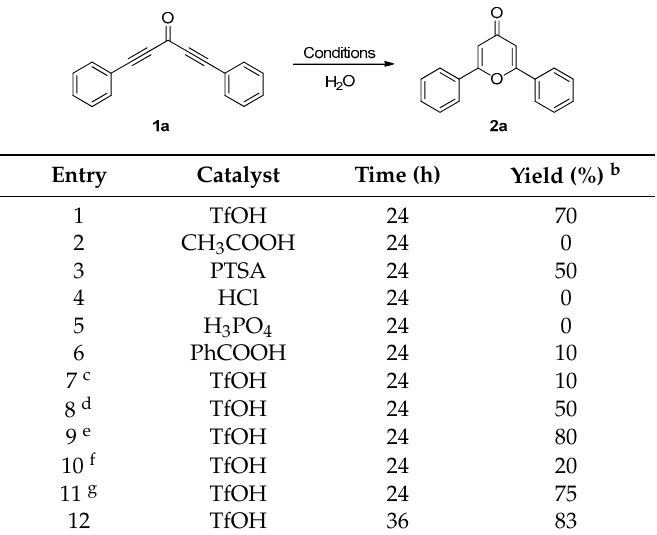
Table 1. Optimization of reaction conditions a .